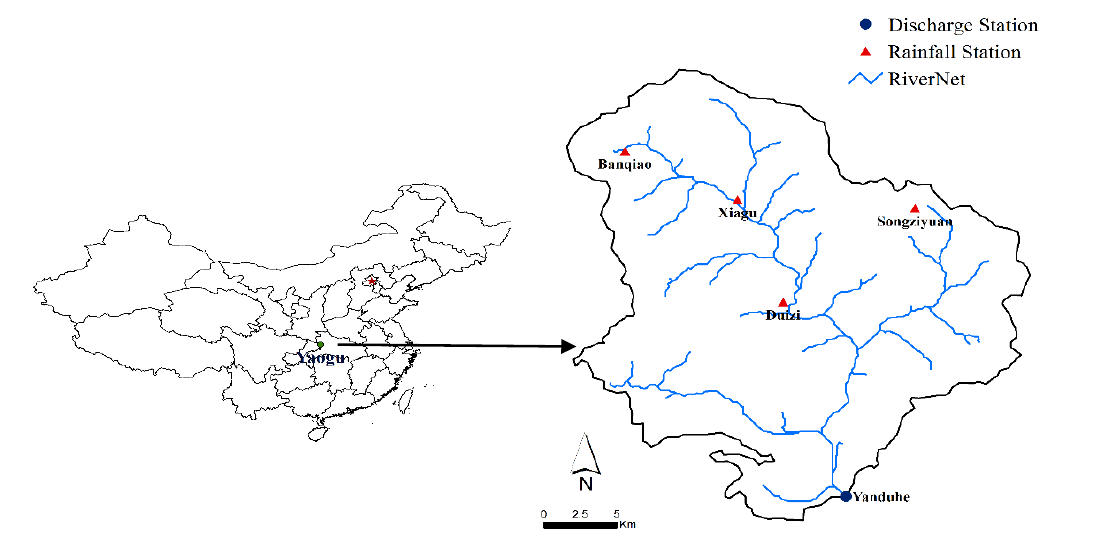
Figure 1. Location and gauging stations of the study